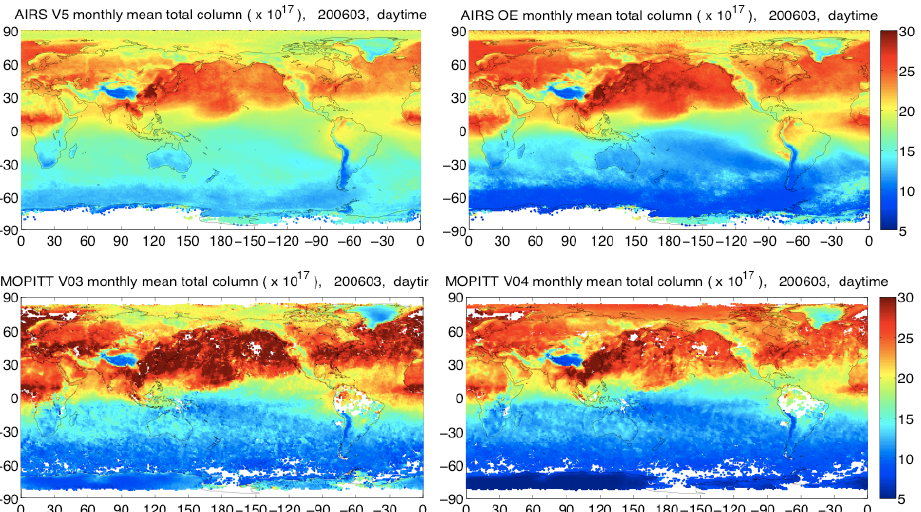
Fig. 8. A comparison of the monthly mean CO total columns ( × 10 17 mols/cm 2 ) between AIRS V5 (top left), OE (top right), MOPITT V3 (bottom left), and MOPITT V4 (bottom right) for March 2006 where the red/blue colors indicate relatively high/low values. Table 2. Modes and the full-width half-maxima (FWHMs) of the Gaussian fits to the CO volume mixing ratio difference probability distribution functions at 500 and 800hPa between AIRS OE and TES V3 products for January to June 2006 over the Northern Hemisphere (NH) land, NH ocean, Southern Hemisphere (SH) land, and SH ocean. 500hPa 800hPa Mode (ppbv) FWHM (ppbv) Mode (ppbv) FWHM (ppbv) NH